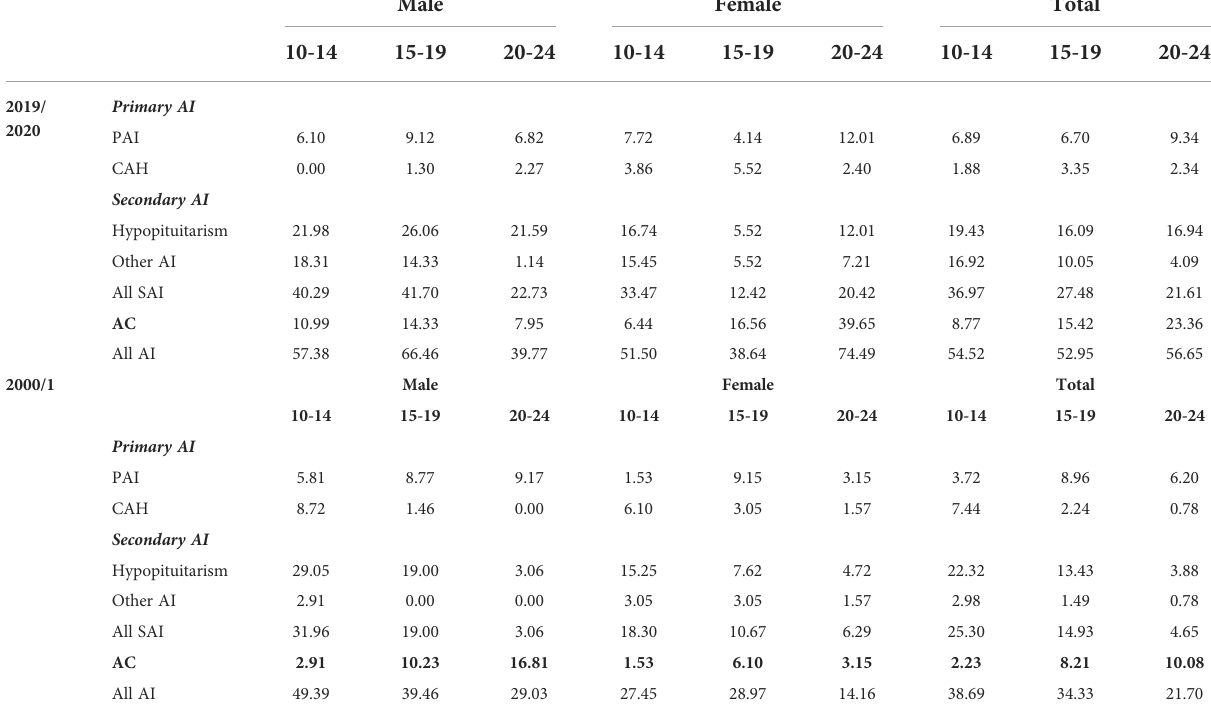
TABLE 2 Admission rates for adrenaI insuf fi ciency by sex and age group in 2000/1 &